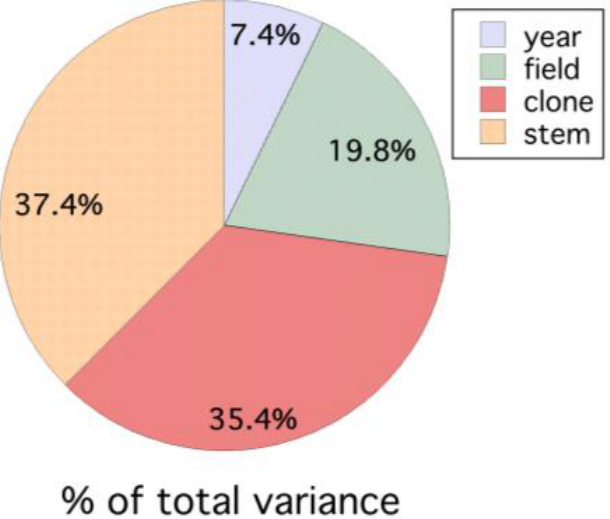
Figure 8. Variance in wild blueberry dropped fruit in eastern Maine, USA, partitioned due to year, field, clone and stem (all variance estimates are significantly different from 0, P < 0.05).